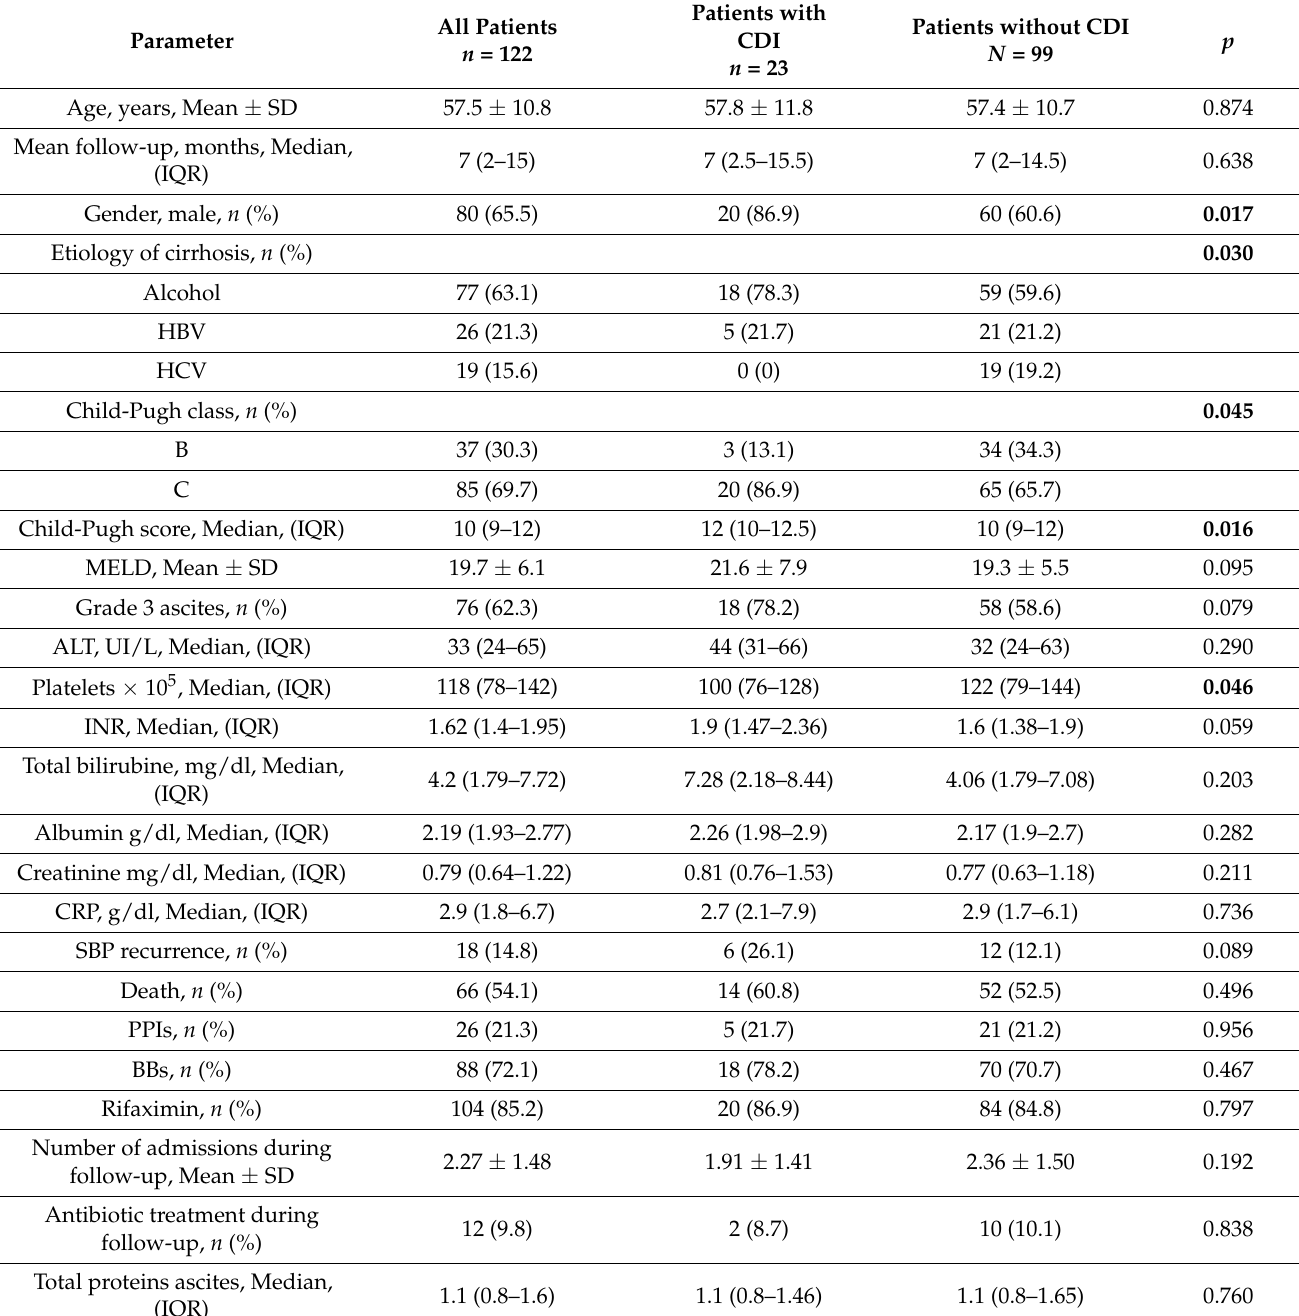
Table 1. The characteristics of the study